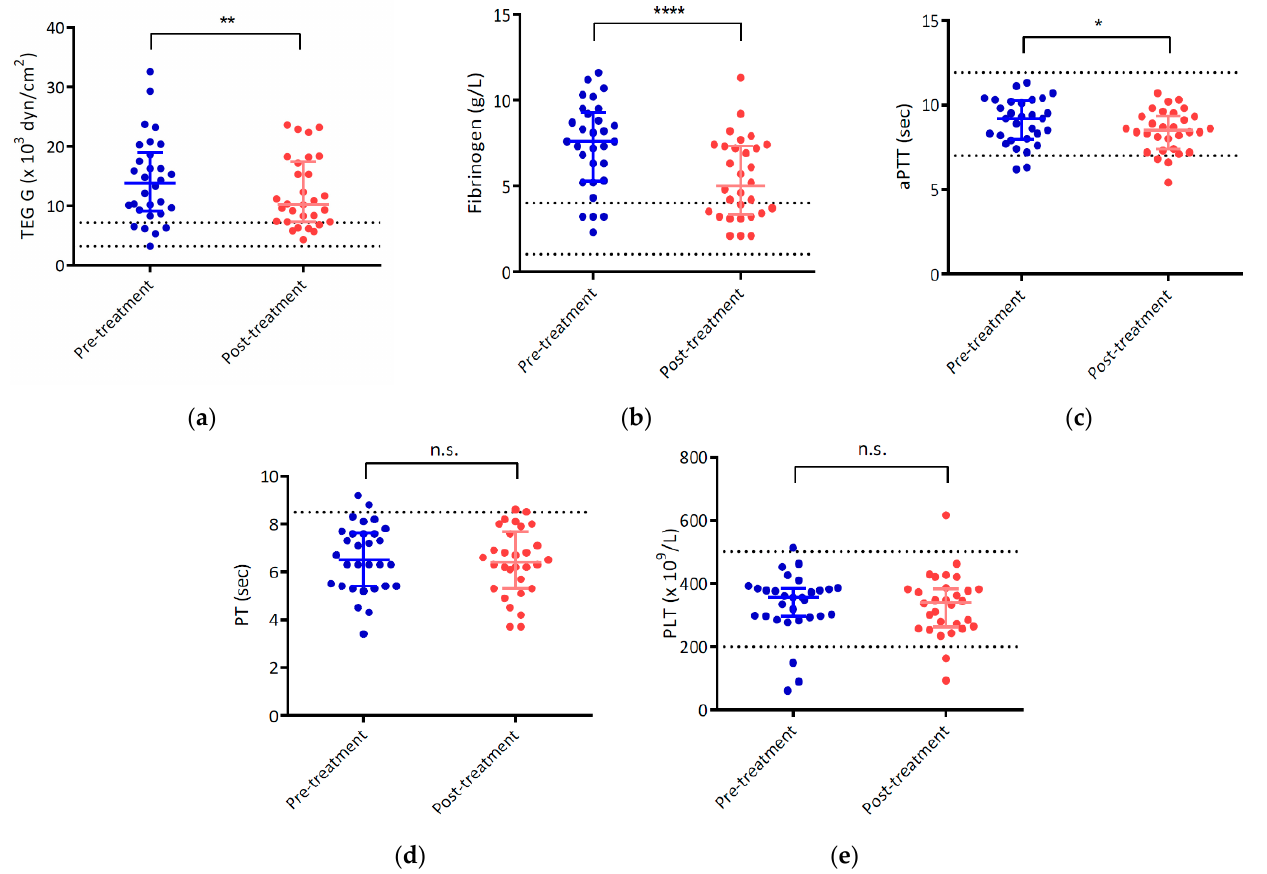
Figure 3. Differences of ( a ) TEG G, ( b ) fibrinogen, ( c ) aPPT, ( d ) PT, and ( e ) PLT before and after tumorectomy. The dotted lines represent the reference interval (TEG G: 3.2–7.2 × 10 3 dyn/cm 2 ; fibrinogen: 1–4 g/L; aPPT: 7–11.9 s; PT: < 8.5 s; PLT: 200–500 10 9 /L). Statistical analysis was performed using GraphPad Prism v9. To determine significant differences between before and after operation, the Wilcoxon matched-pairs signed-rank test was utilized and p values < 0.05 were considered as indicating statistical difference. Data are presented as median ± interquartile range. TEG G, thromboelastography G; aPPT, activated partial thromboplastin time; PT, prothrombin time; PLT, platelet count; *, p < 0.05; **, p < 0.01; ****, p < 0.0001; n.s., no significant difference.